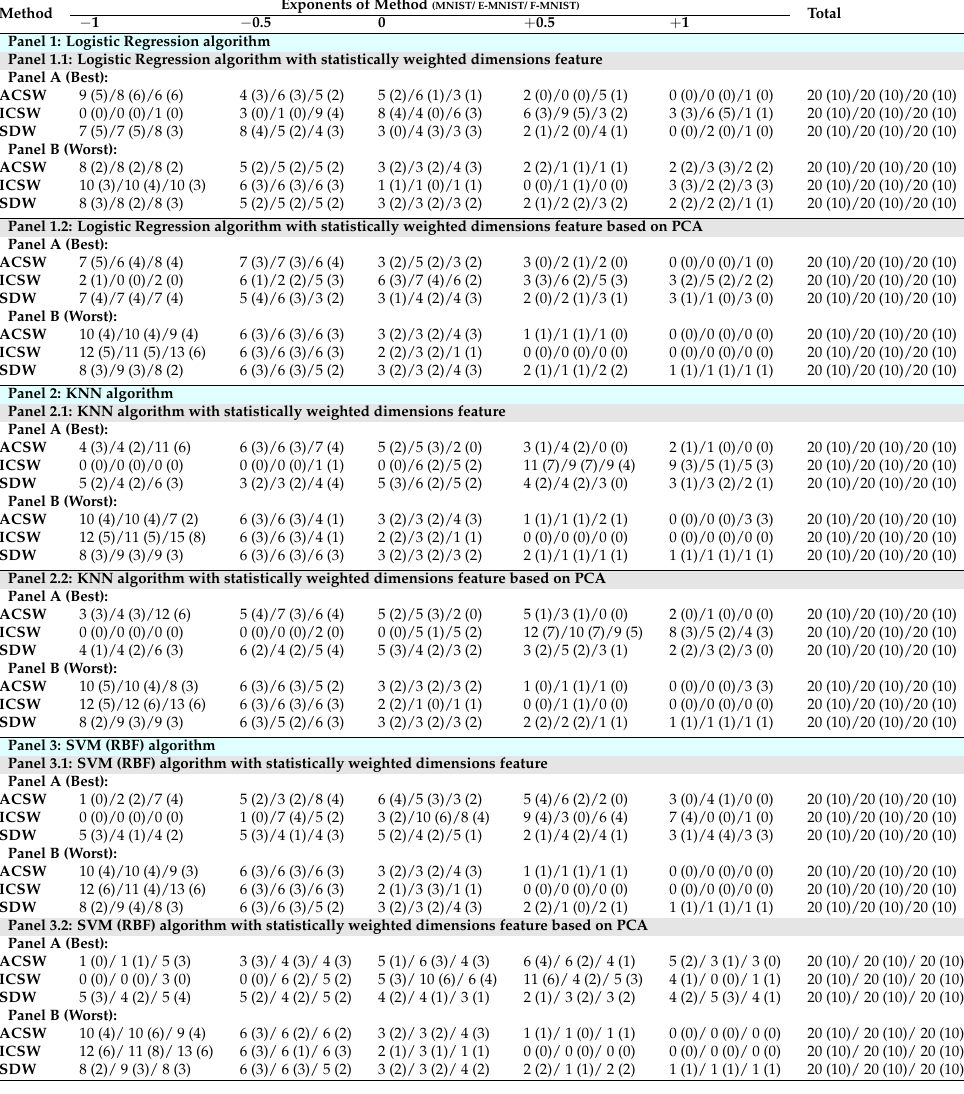
Table 3. The statistically-weighted dimension feature distribution factors ( ACSW , ICSW , SDW ) analysis on varied exponents on three image classification algorithms with Logistic Regression, KNN, and SVM (RBF) and three datasets (MNIST/ EMNIST/ F-MNIST) for the number of feature weightings (combinations) of Best-20 (Best-10) and Worst-20 (Worst-10). Method ExponentsofMethod (MNIST/E-MNIST/F-MNIST) Total − 1 − 0.5 0 + 0.5 + 1 Panel1: LogisticRegressionalgorithm Panel1.1: LogisticRegressionalgorithmwithstatisticallyweighteddimensionsfeature PanelA(Best): ACSW